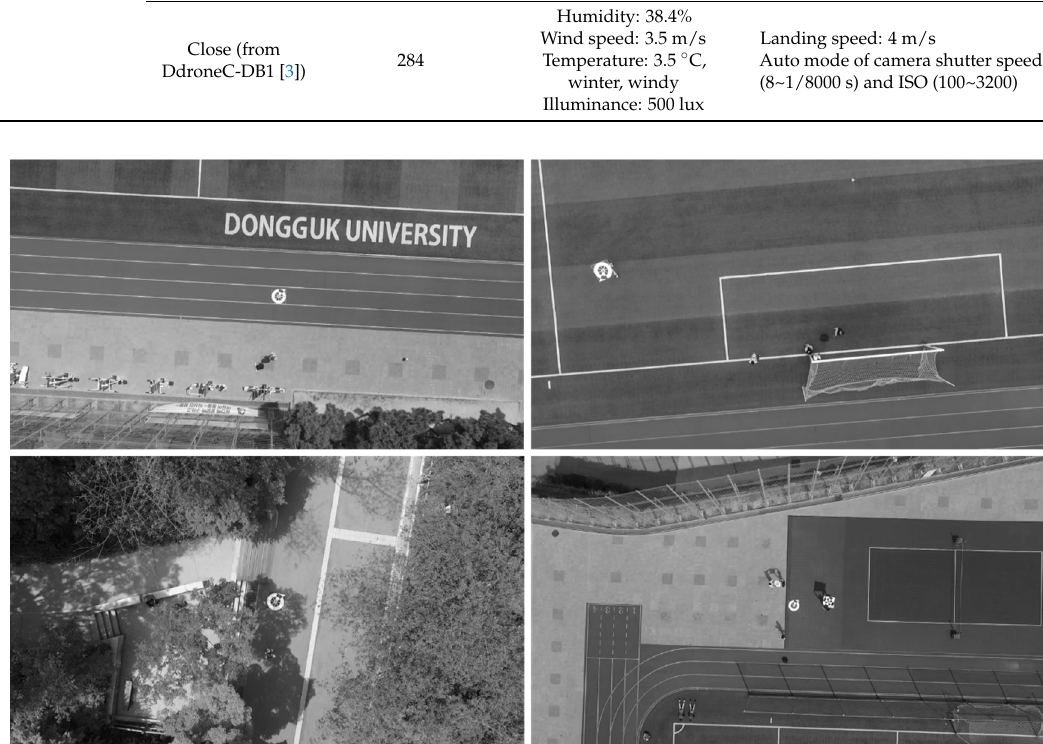
Figure 12. Examples of images in our DDroneC-DB2 dataset.